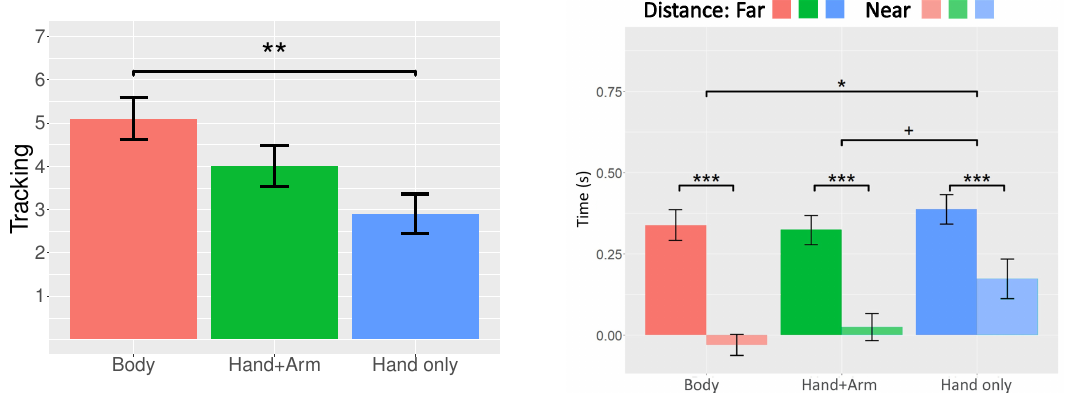
Figure 7. ( Left ) Result of Q2 (Tracking); and ( right ) result of time difference. All error bars represent standard